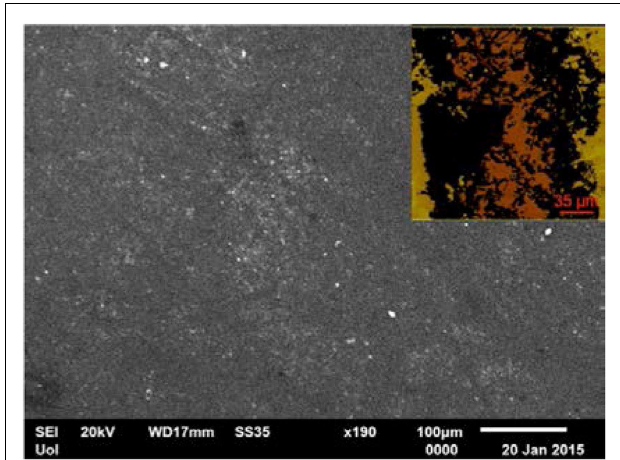
FIGURE 6 | Representative SEM image of ODA–rGO–ODA–C 60 . Inset: AFM micrograph of the same sample used for the surface roughness